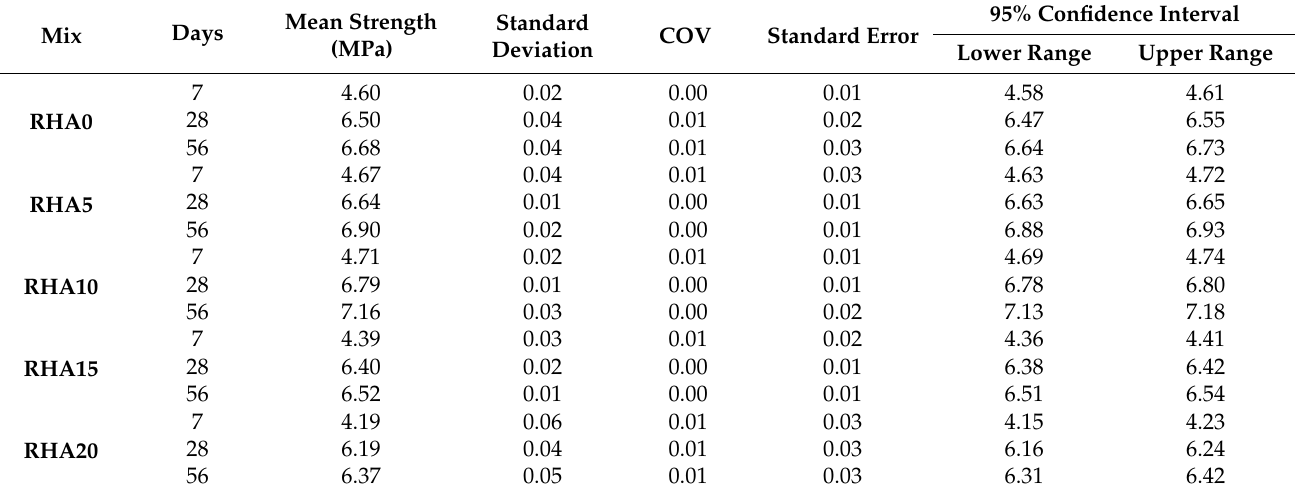
Table 5. Summary of the splitting tensile strength test outcomes.